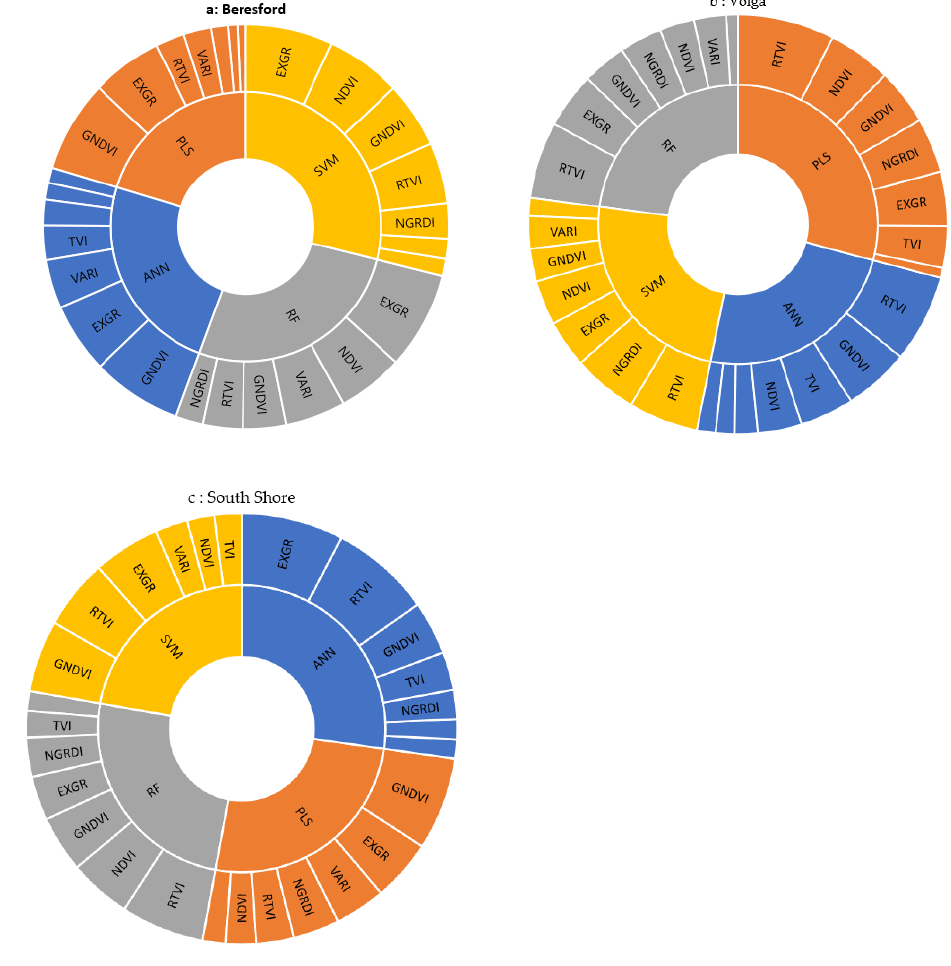
Figure 11. Importance scores for predictor variables. The importance scores of predictors are sum- marized considering all locations and model types.